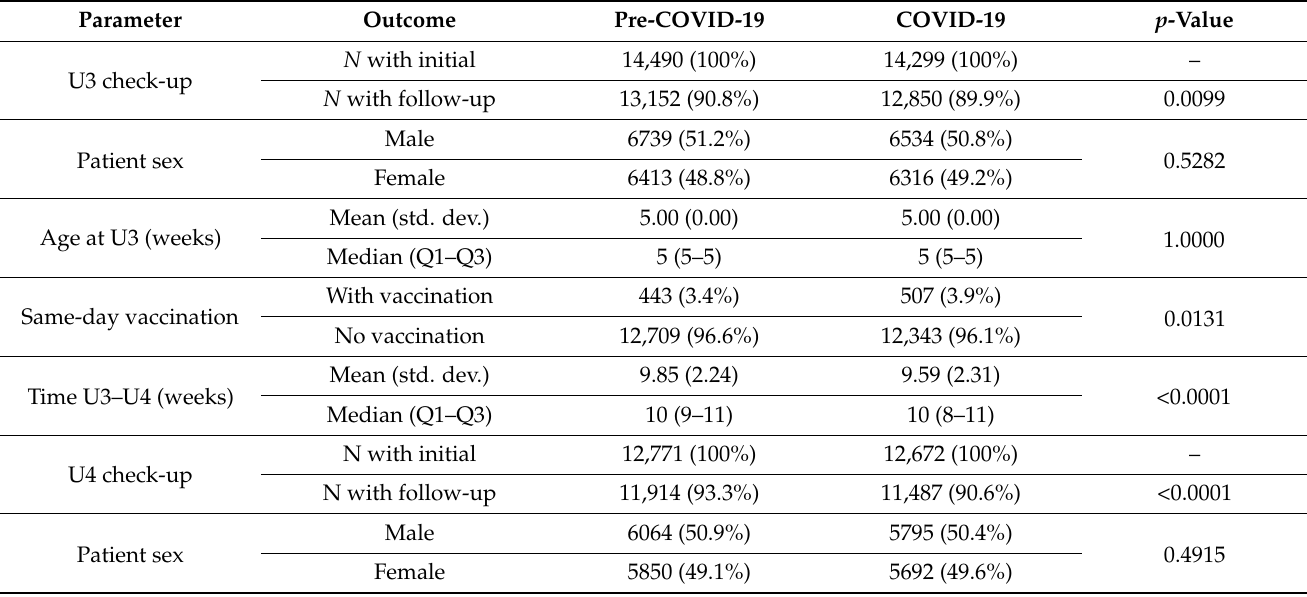
Table 3. Results of the analysis of paediatric check-ups for each pair of initial and follow-up events. Percentages of N with follow-up are given in relation to N with initial event. For other categories, the percentages are in relation to N with